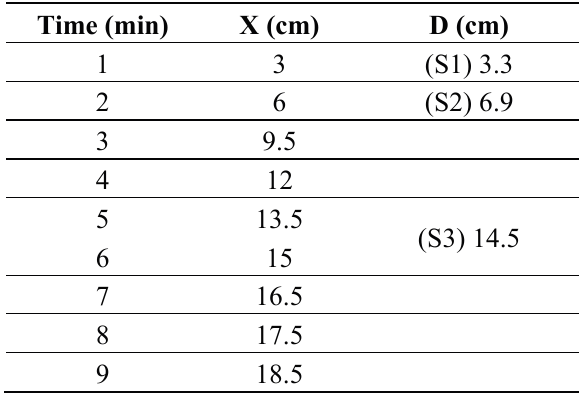
Table 1. Time, resin front and PPS sensor’s